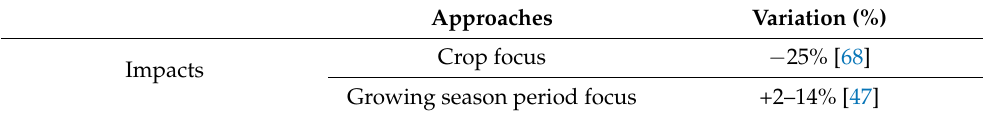
Table 2. Variation of irrigation water requirements in the context of